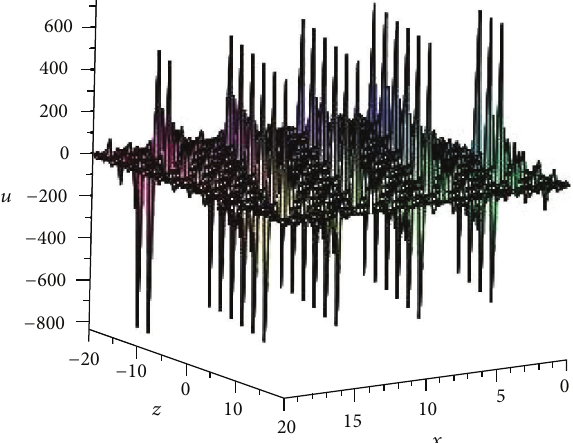
Figure 3: The shape of the 1-positon of zero-order to (1) with 𝜆 1 = 2 , = 0 𝑦 = 0 , 𝑡 = 1 , 𝛾 3